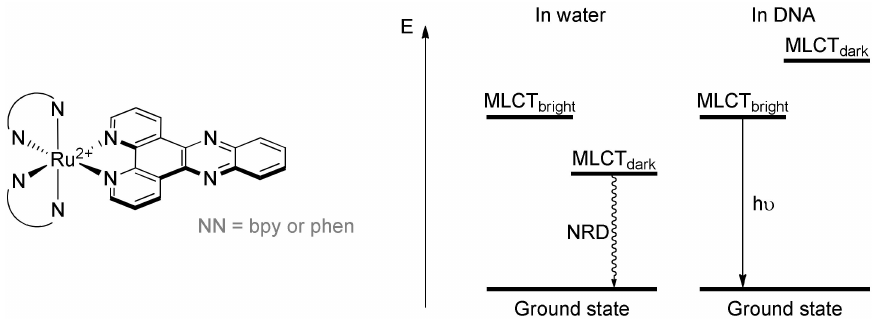
Figure 13. Structure of [Ru(L) 2 ( dppz )] 2+ (L = bpy or phen) and energy diagram of the excited states involved in the light-switch effect in function of the environment around the complex. NRD = non-radiative